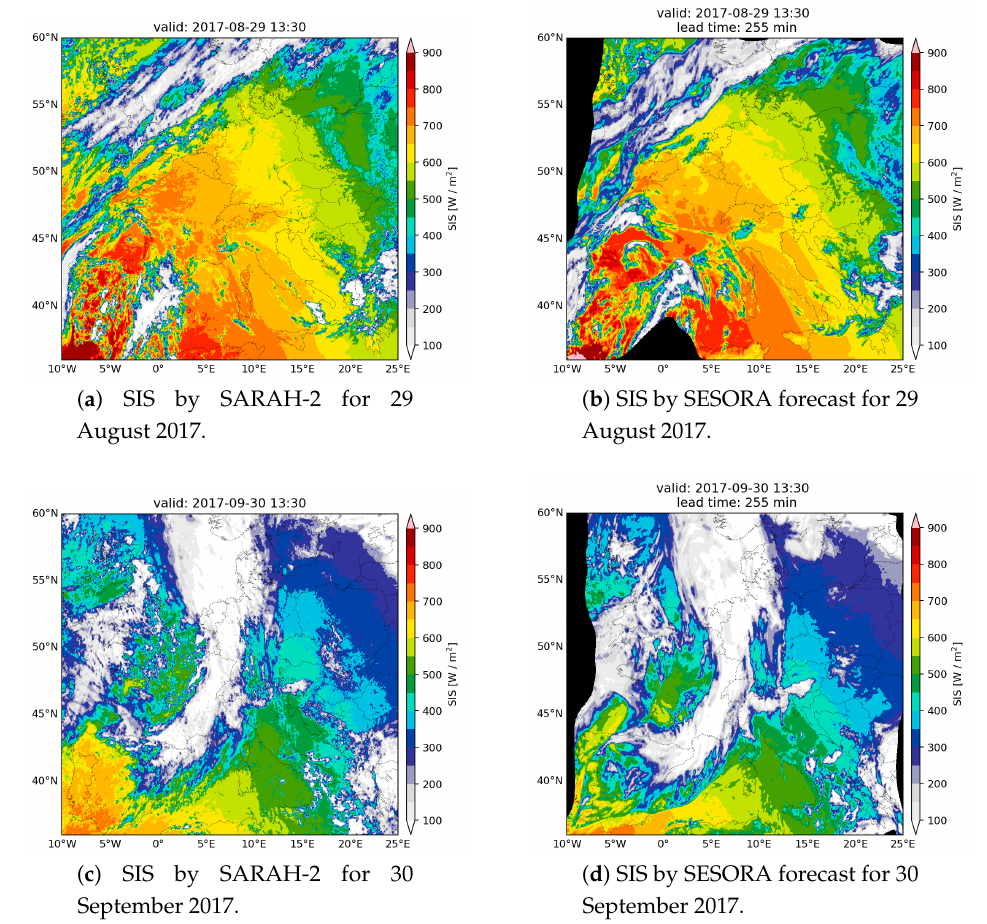
Figure 2. Plot of solar surface irradiation for 29 August 2017 (upper) and 30 September 2017 (lower). ( a , c ) show the estimated SIS (Surface Incoming Shortwave Radiation) by SARAH-2 (Surface Solar Radiation Data Set - Heliosat) and ( b , d ) show the forecasted SIS by SESORA (Seamless Solar Radiation) after 255 min of forecast